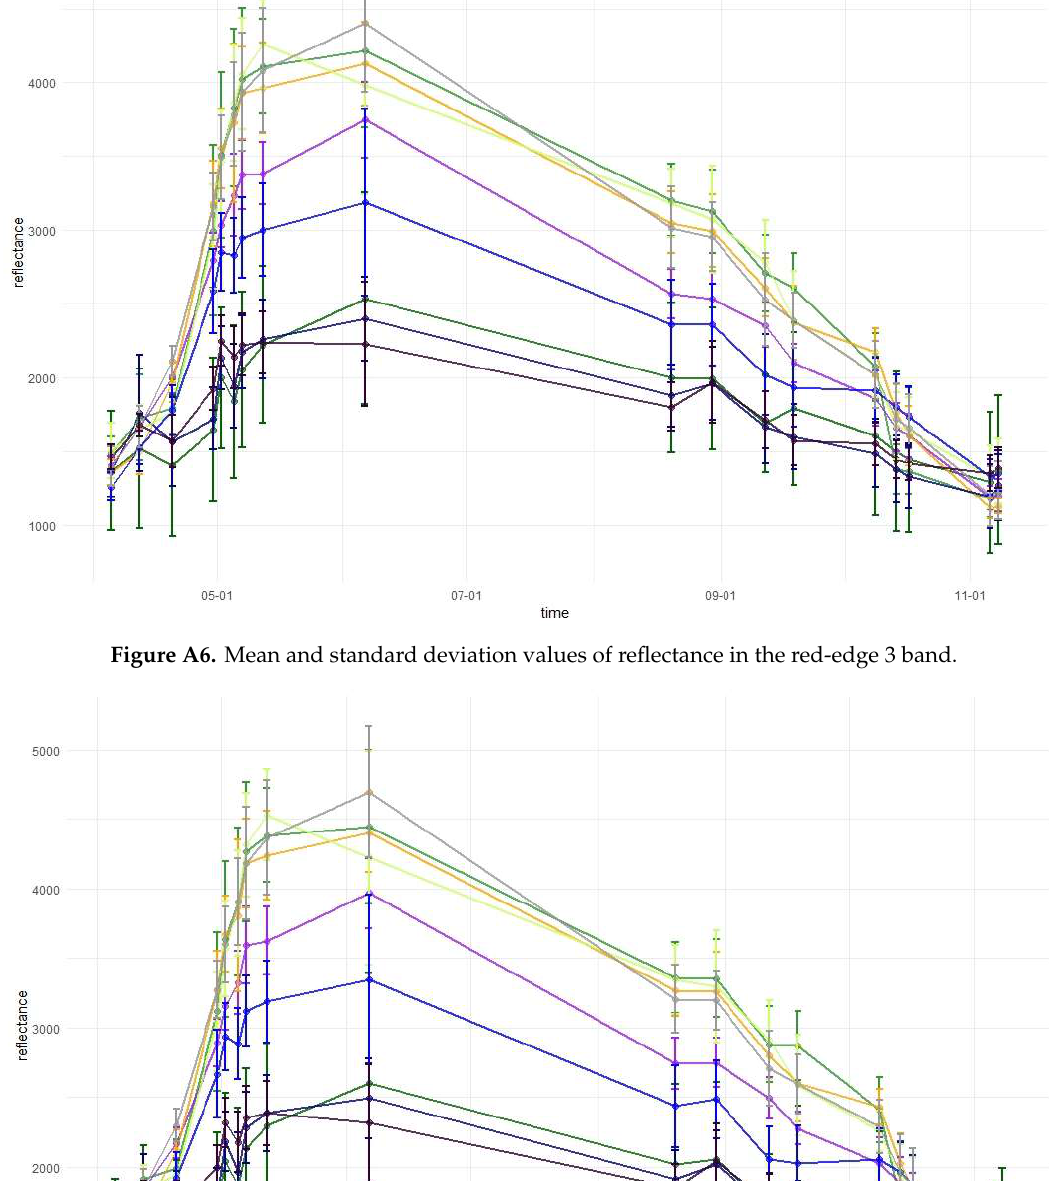
Figure A5. Mean and standard deviation values of reflectance in the red-edge 2 band.